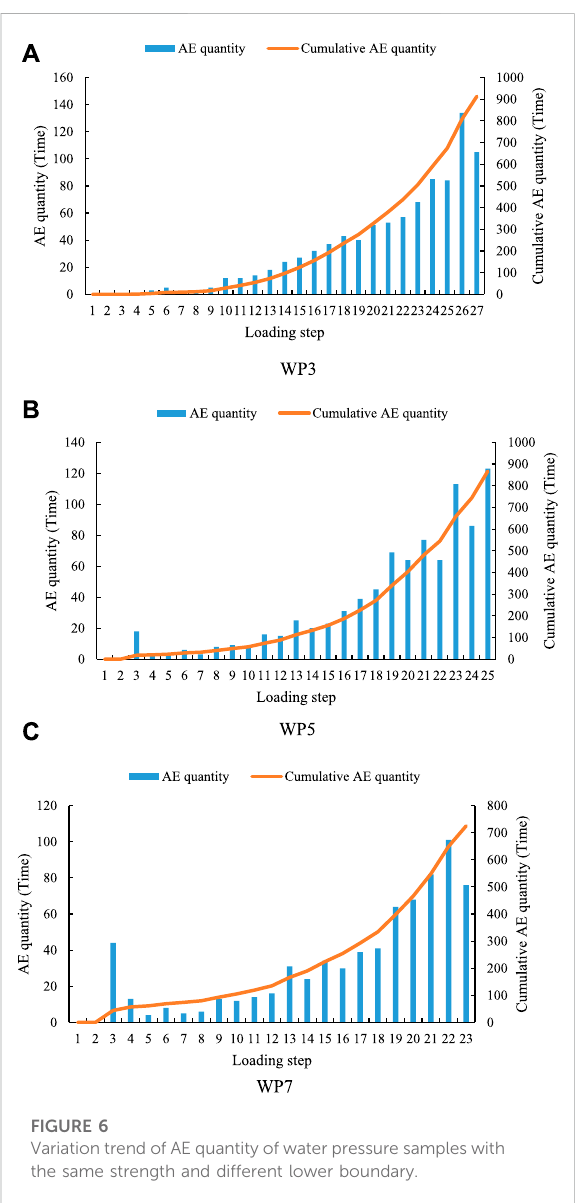
FIGURE 7 AE energy variation trend of water pressure samples with the same strength and different lower boundaries.